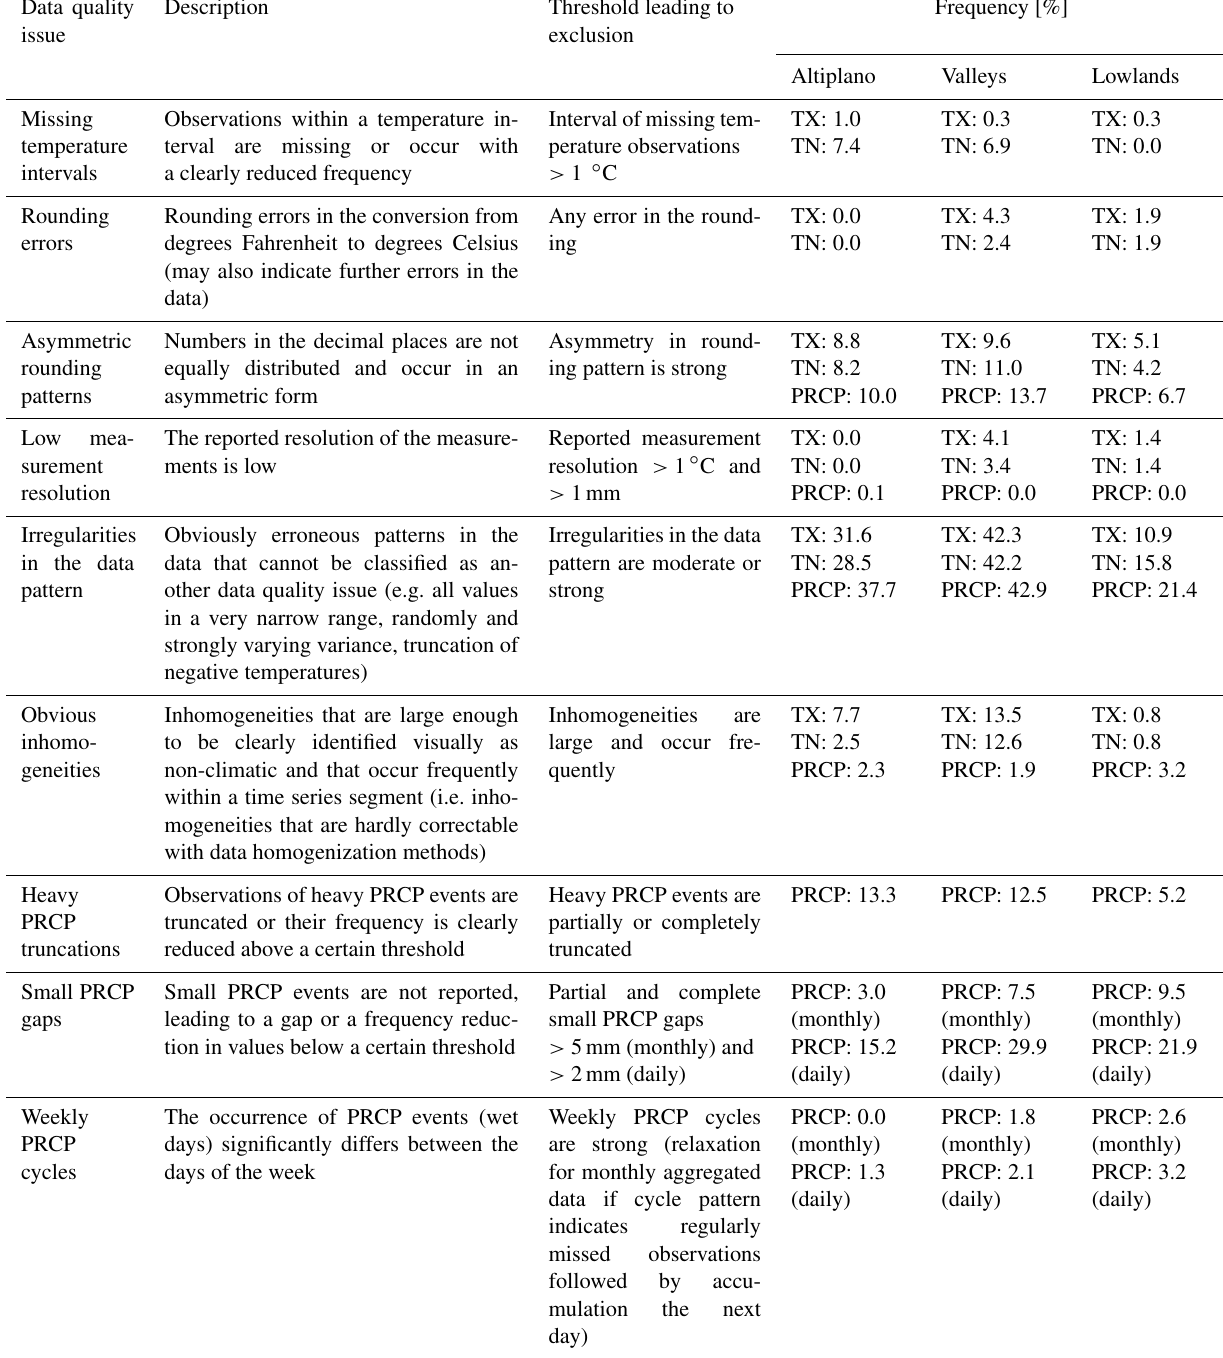
Table 1. Description of systematic data quality issues and their frequencies in the DECADE database (station records with ≥ 20 years of observations) between 1981 and 2010. If not specified, the frequencies of data quality issues apply to daily observations and monthly aggregations. Frequencies of the data quality issues in maximum (TX) and minimum (TN) temperature and precipitation (PRCP) observations are shown for the different regions (Altiplano, valleys, and lowlands; see Fig. 1). Thresholds leading to the exclusion of data were chosen so that data quality issues should not affect the subsequent climatological analyses of the daily and monthly aggregated data. For other analyses, these thresholds may not be adequate and consequently the frequencies of relevant data quality issues may differ. Tests were done in parallel, and time series segments may therefore be affected by several data quality issues simultaneously. For a detailed description of frequent data quality issues, see Hunziker et al.